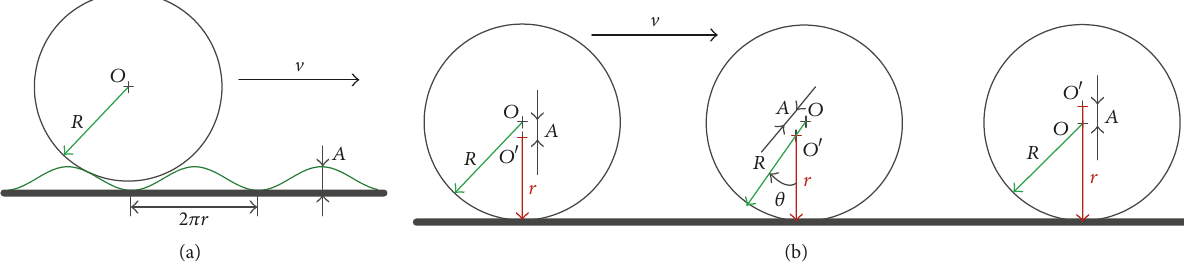
Figure 8: Methods to describe the wheel OOR: (a) transforming into track irregularity and (b) the harmonic deviation.